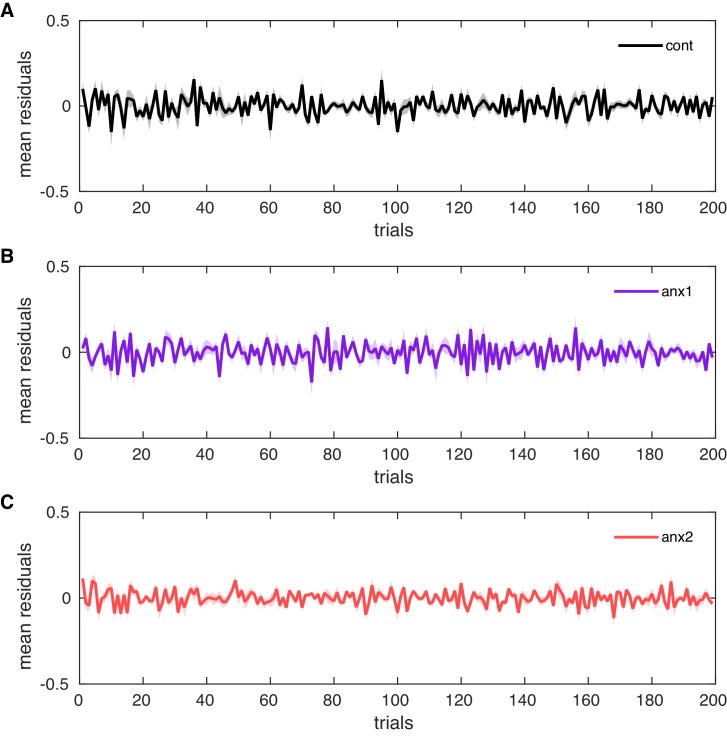
Grand-average trialwise residuals.Grand-average trialwise residuals resulting from the difference between the observed responses and the responses predicted by the HGF. (A–C) The trialwise residuals in each control and experimental group are shown together as mean and SEM (shaded areas). The winning response model used as response variable the trial-by-trial change in cvIKItrial, which is related to the temporal variability of IKI across keystroke positions in a trial. There were no systematic differences in the model fits across groups (P>0.05; between-group differences in the mean residual, after averaging across trials — cont: 0.0004[0.00095]; anx1: -0.001⁢[0.0013]; anx2: 0.0003⁢[0.0003]). In the additional control experiment, we also found no significant differences between groups in the mean residual values (mean residual values per group: cont: -0.0003⁢[0.00047]; anx3: −0.0023[0.0016]).